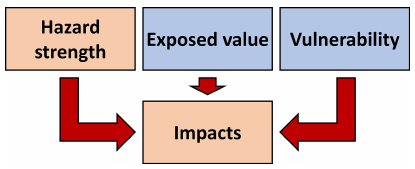
Figure 1. Hazard event impacts as a result of hazard strength, ex- posed value, and vulnerability of exposed